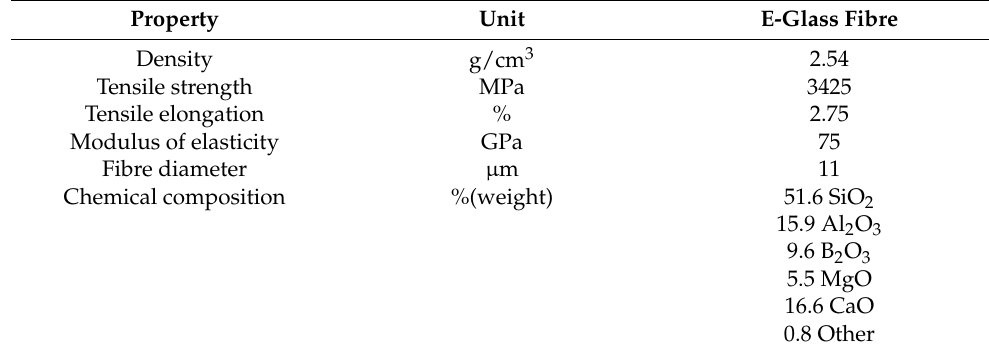
Table 1. Properties of E-glass fibre.